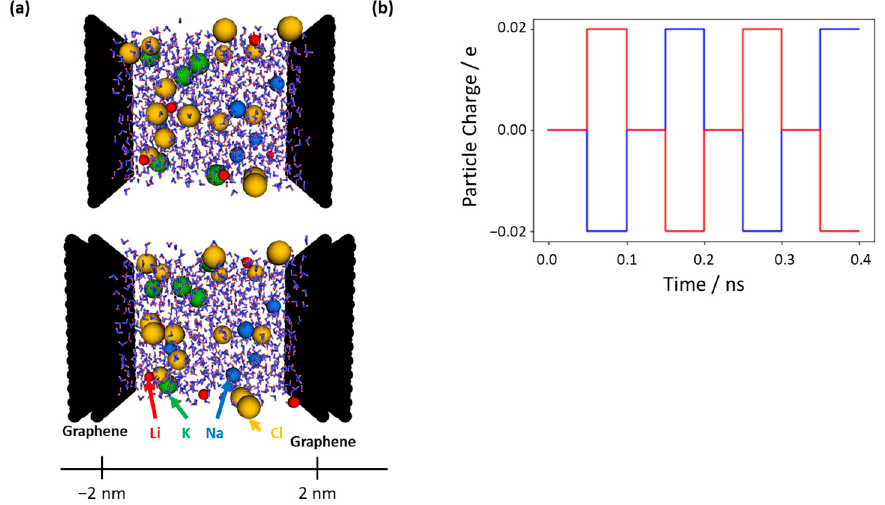
Figure 4. ( a ) Snapshot of aqueous electrolytes between single-layer graphene and bilayer graphene. Li, Na, K, and Cl ions are represented by red, blue, green, and yellow spheres, respectively. O and H atoms in H 2 O are illustrated by blue and red sticks, respectively. A carbon atom is represented by a large black sphere. ( b ) Conditions of the applied partial charges ( ± 0.02 e) of carbon atoms on the right- and left-side graphene.